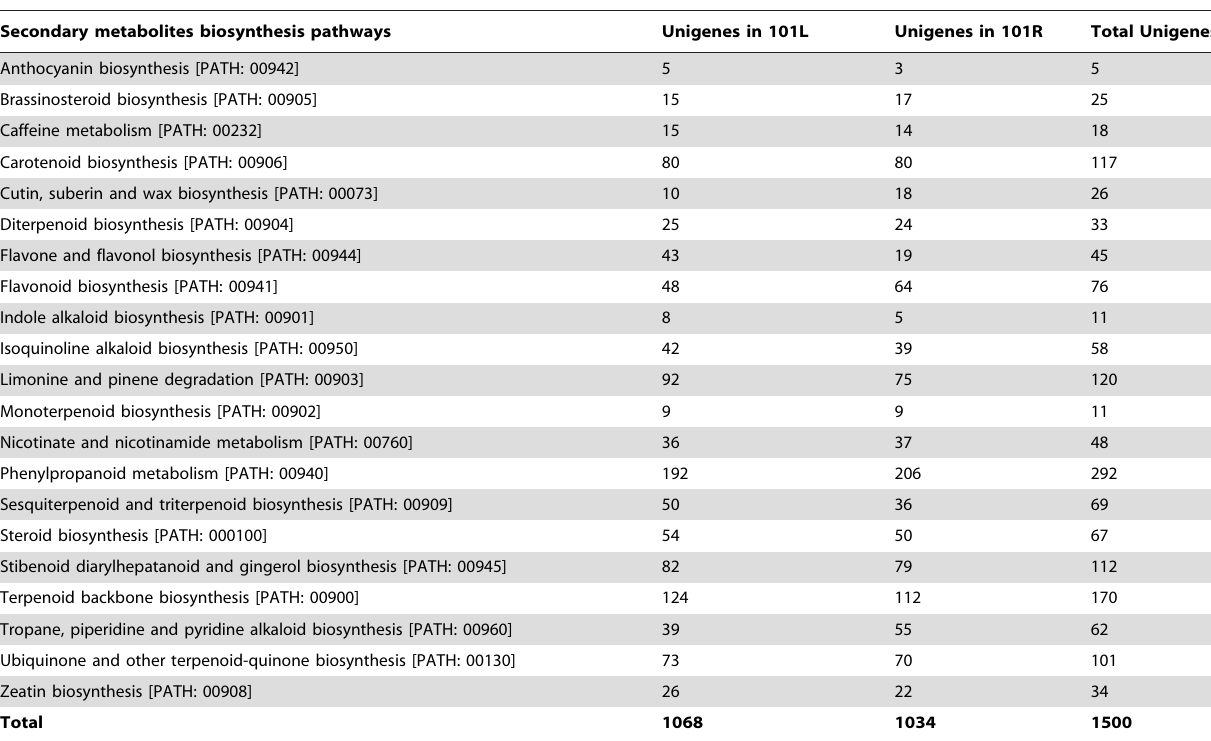
Table 3. The unigenes related to secondary metabolites in 101L and